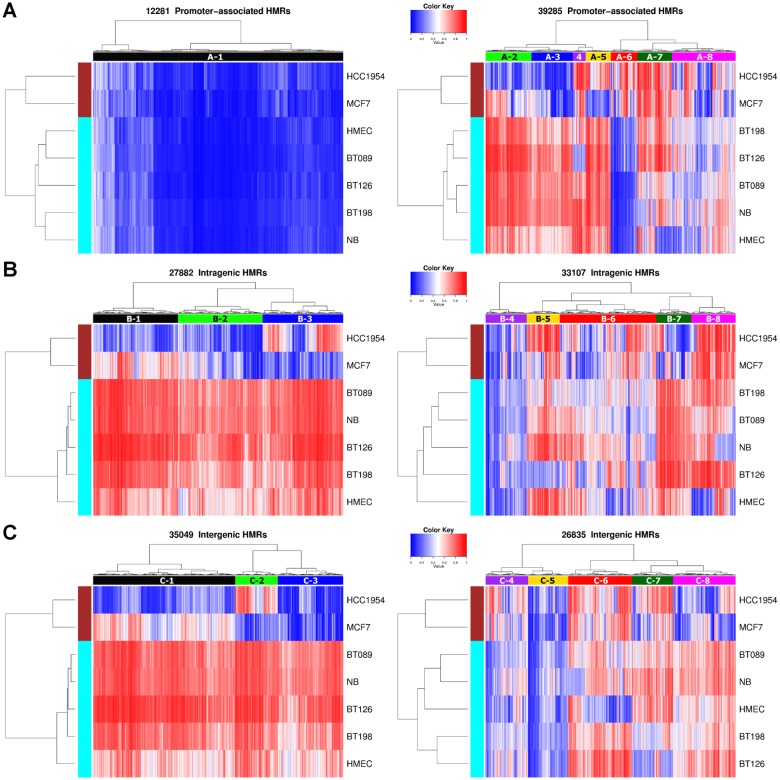
Hierarchical clustering of promoter, intragenic and intergenic HMRs according to their DNA methylation levels in the seven breast methylomes.Coloring indicates methylation levels from low (blue) to high (red). Eight distinctive HMR clusters were indicated in each of the three genomic locations. (A) Promoter HMRs. The A-1 cluster represents the promoter HMRs that were consistently lowly methylated in all seven samples. (B) Intragenic HMRs. The B-1, B-2 and B-3 clusters were hypomethylated in one or both cancer cell lines (MCF7 and HCC1954), while other samples remain methylated. (C) Intergenic HMRs. The C-1, C-2 and C-3 clusters were hypomethylated in one or both cancer cell lines (MCF7 and HCC1954), while other samples remain methylated.